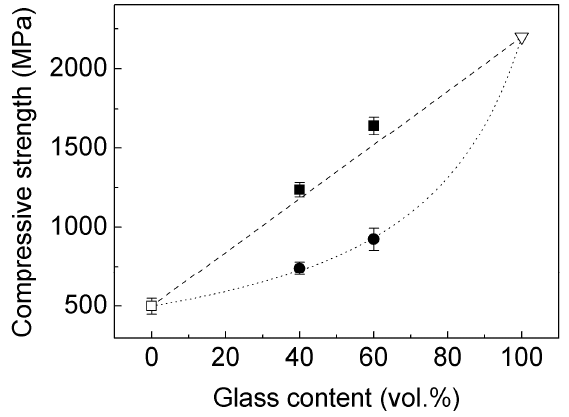
Figure 13. Compressive strength (evaluated from Figure 7) as a function of volume fraction V of glass reinforcement for: (  ) pure brass, (  ) blended and (  ) milled composites, (  ) single-phase Ni iso-strain (dashed line) and iso-stress (dotted line) models through Equations (1) and